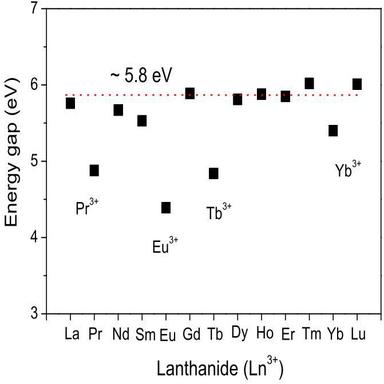
Relationship between the measured band gap and lanthanide ion present in the pyrogermanate matrix. The medium value at about 5.8 eV is represented by a dotted line, being only a guide for the eyes.